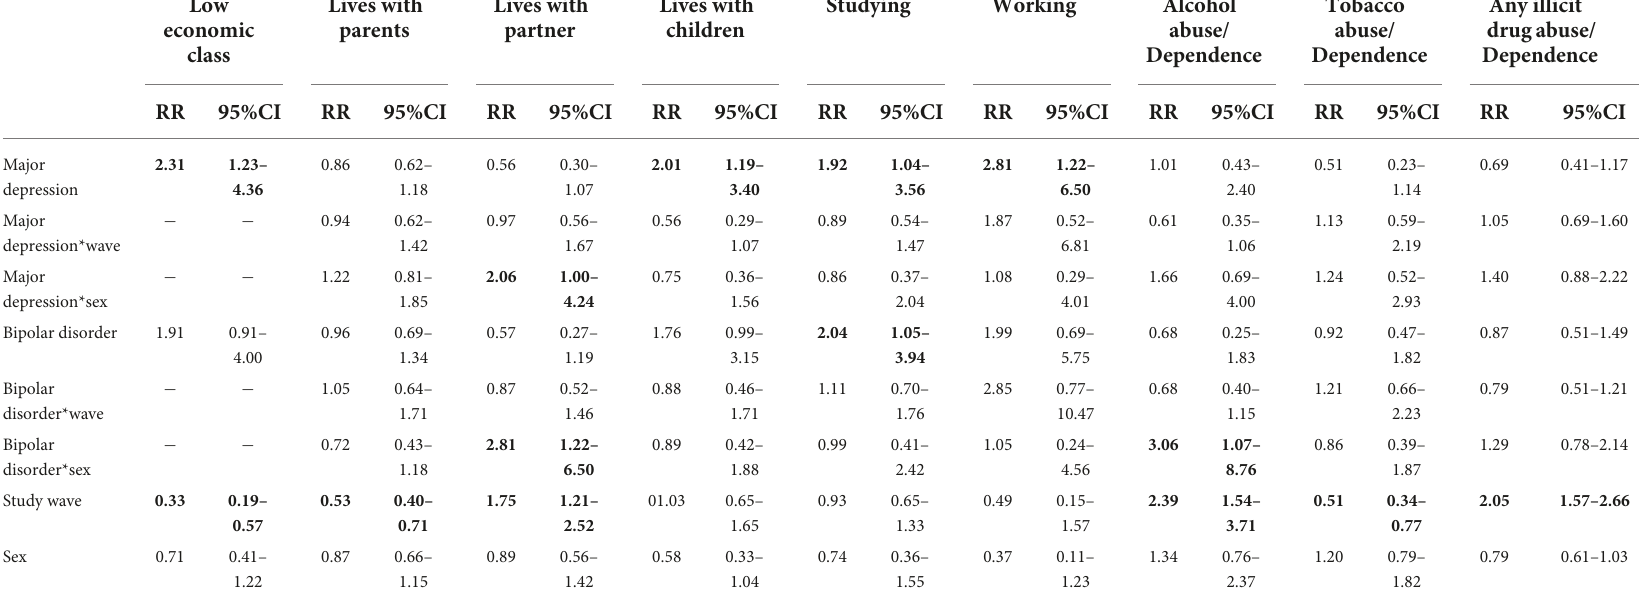
Boldvaluesrepresentp ≤ 0.05.